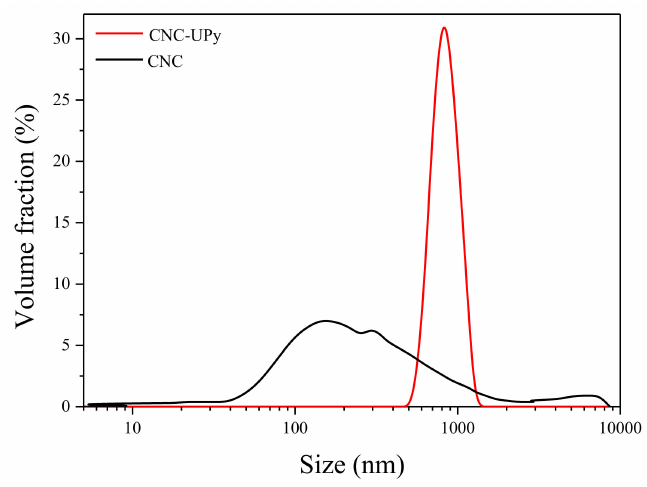
Figure 4. PSDcurves of CNC and CNC-UPy.